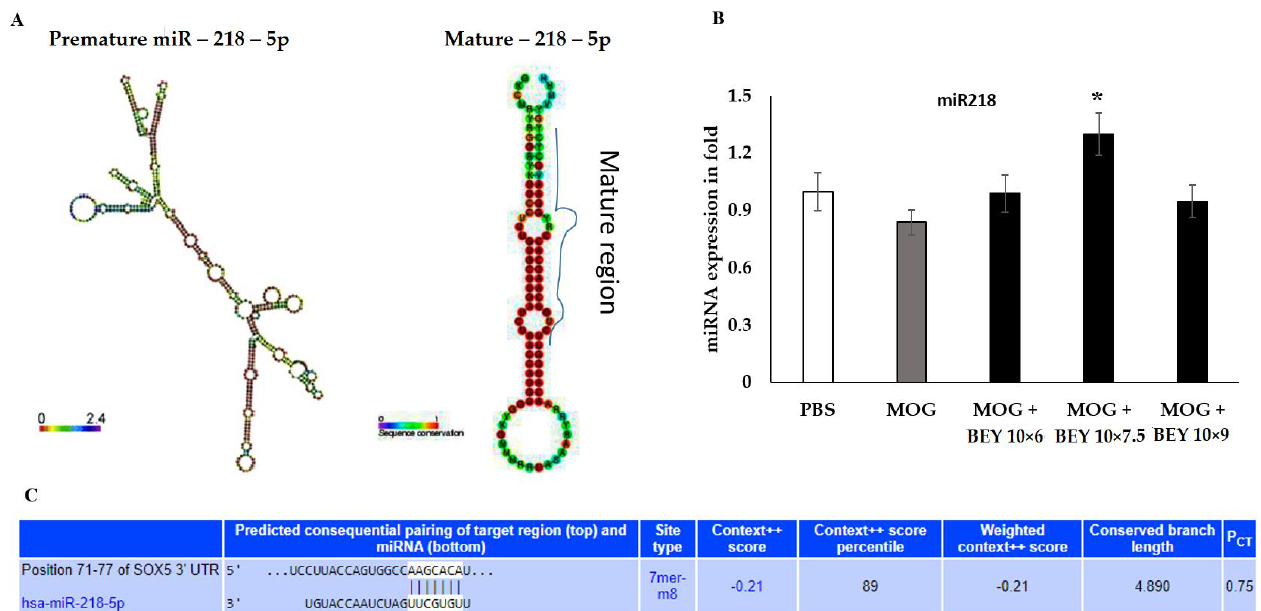
Figure 2. Effect of BEY on epigenetic hindrance of SOX5 expression. ( A ) SOX5 predominant miRNA target miR218 was identified using target scanning. ( B ) The expression of miR218-5p was quantified using Real-Time PCR. The results were reciprocally correlated with SOX5 protein expression. ( C ) miR-218-5p targets mice SOX5 3’ UTR regions from 71-77 basepair and it was confirmed by insilico target scan tool. Values are expressed using Student ’s t -test and one-way ANOVA (significant at * p ≤0.05, ** p ≤ 0.01 ).